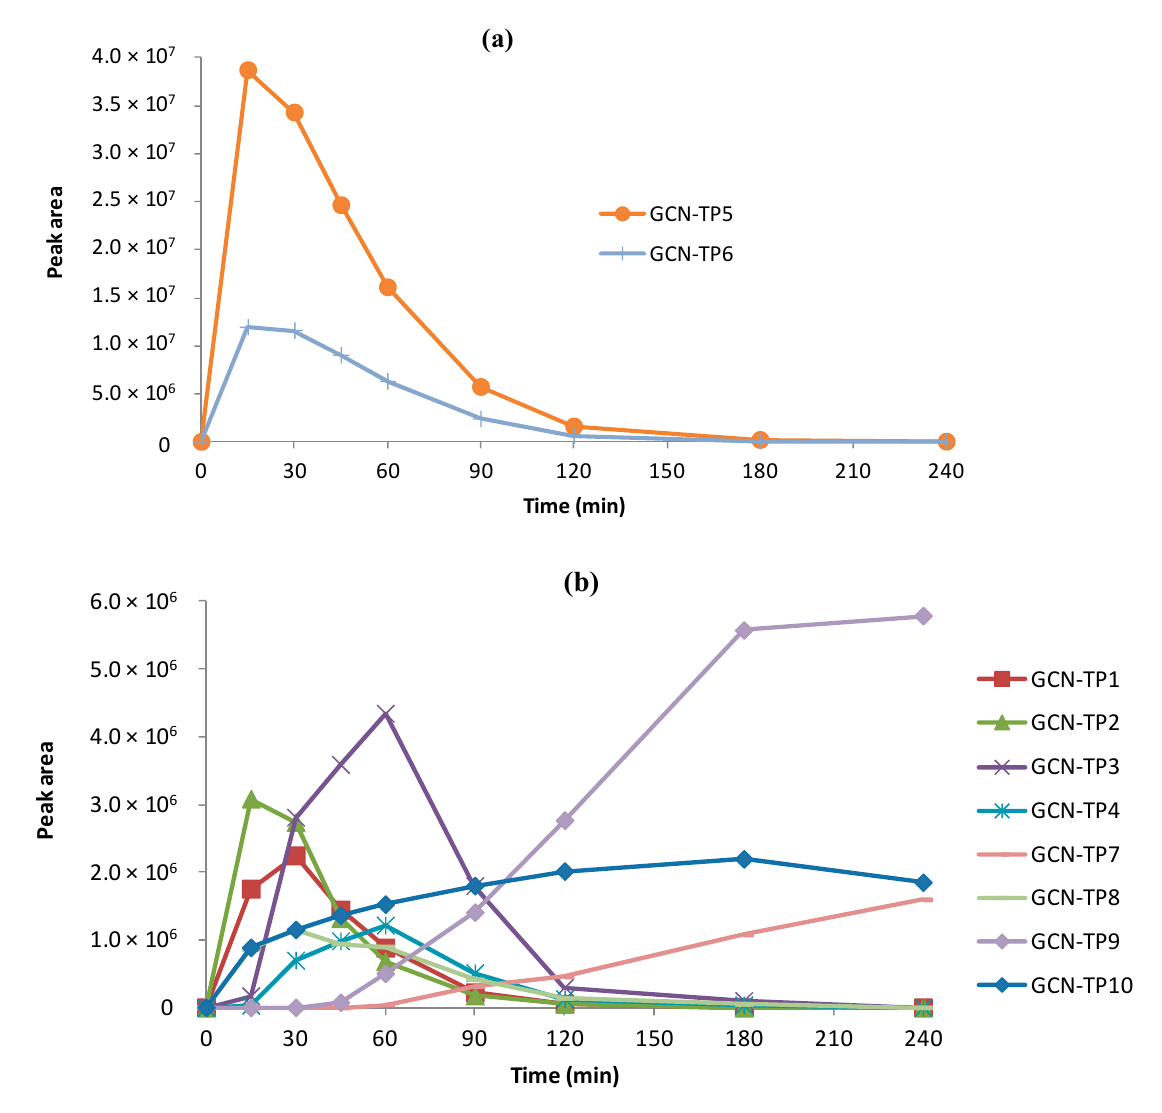
Figure 3. Evolution profiles of major ( a ) and minor ( b ) VLS TPs by g-C 3 N 4 photocatalytic oxidation process.